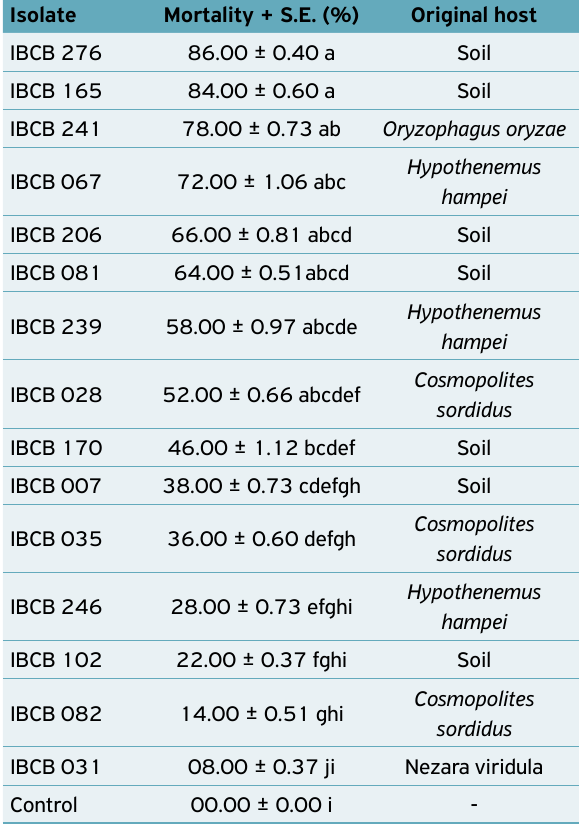
Table 2. Mortality of Conotrachelus psidii larvae by Beauveria bassiana isolates, standardized to 1.0 × 10 7